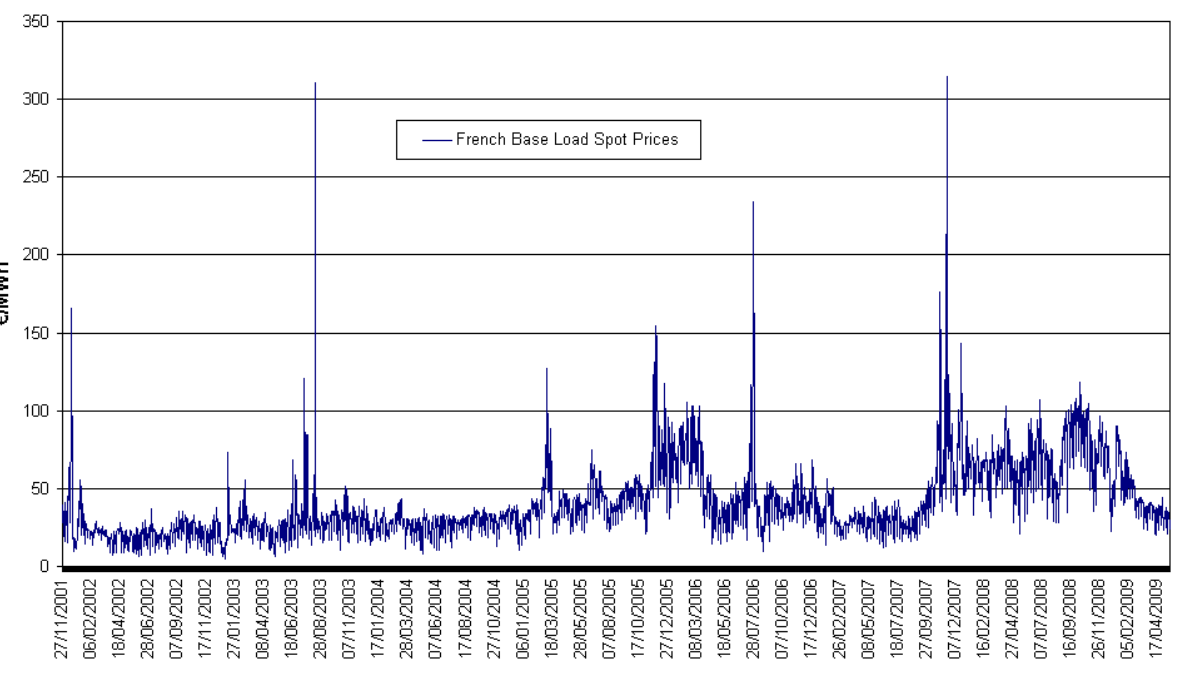
Figure 2. Base load electricity prices on Powernext